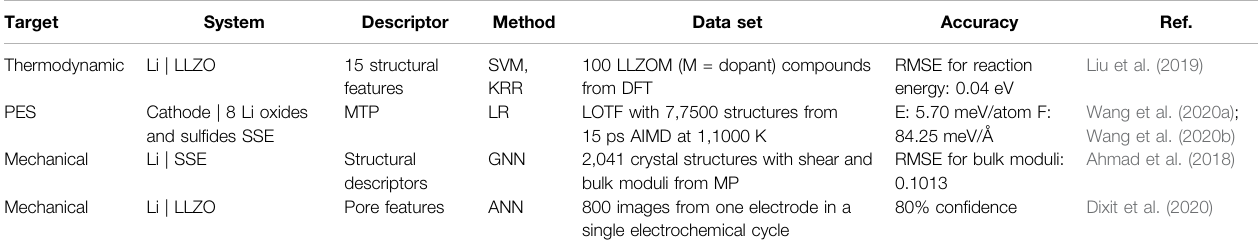
TABLE 4 | Summary of ML applications in interfaces and